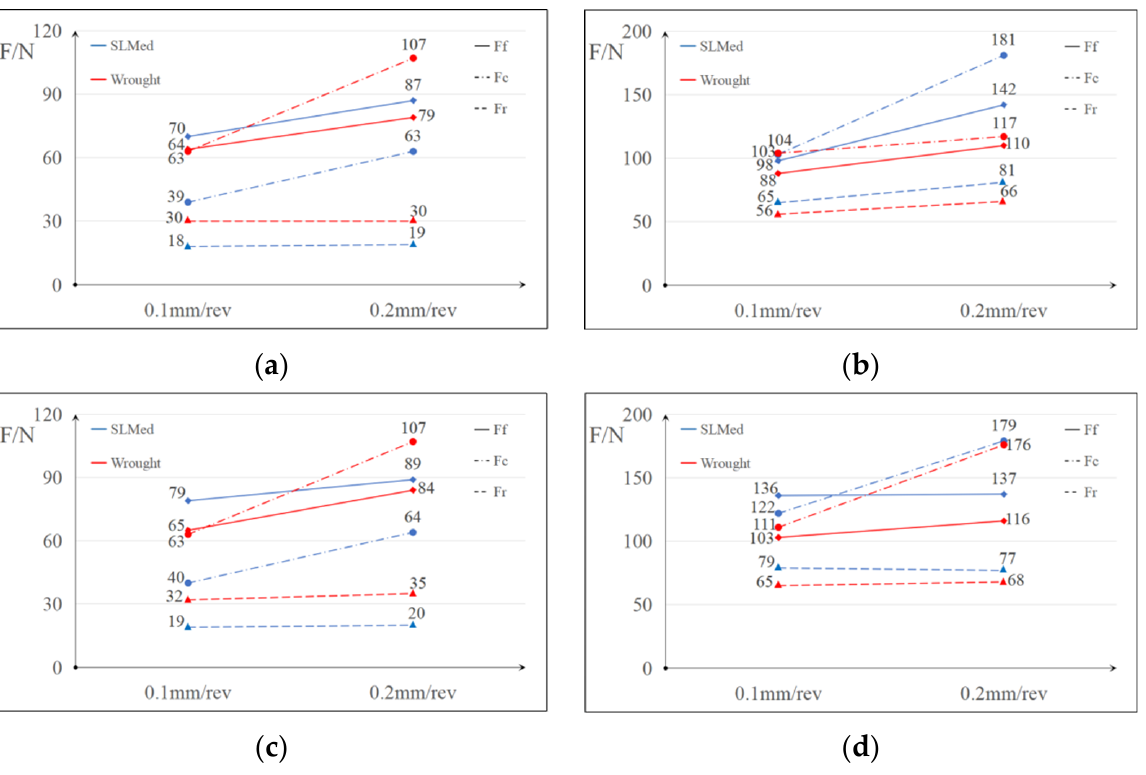
Figure 7. Average values of the three-axis cutting forces at different cutting parameters: ( a ) cutting depth 0.25 mm, cutting speed 80 m/min, ( b ) cutting depth 0.25 mm, cutting speed 120 m/min, ( c ) cutting depth 0.5 mm, cutting speed 80 m/min, ( d ) cutting depth 0.5 mm, cutting speed 120 m/min.